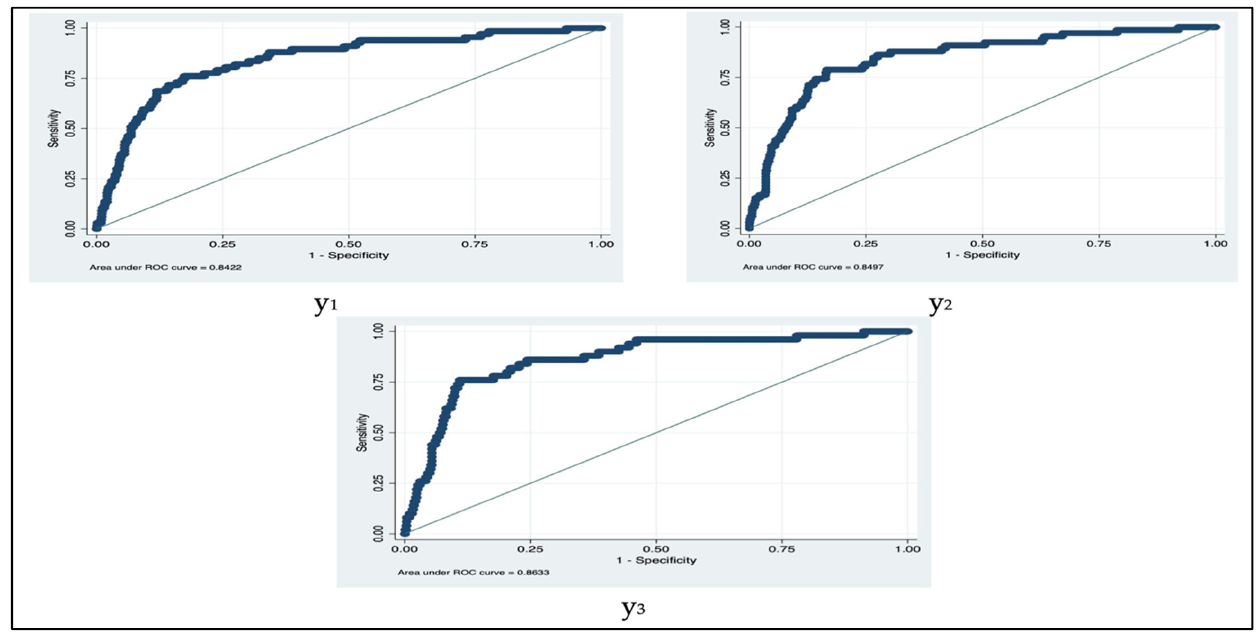
Figure 2. ROC curve for y 1 , y 2 and y 3 (model 4).